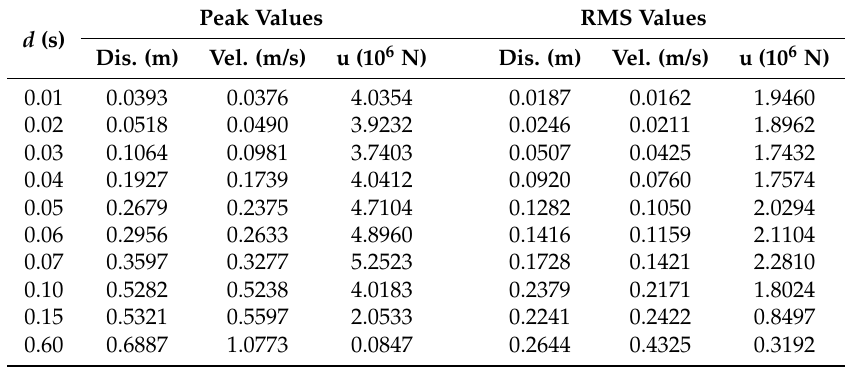
Table 2. Response peak and RMS values of the structure and control force with PD-FOFCs.